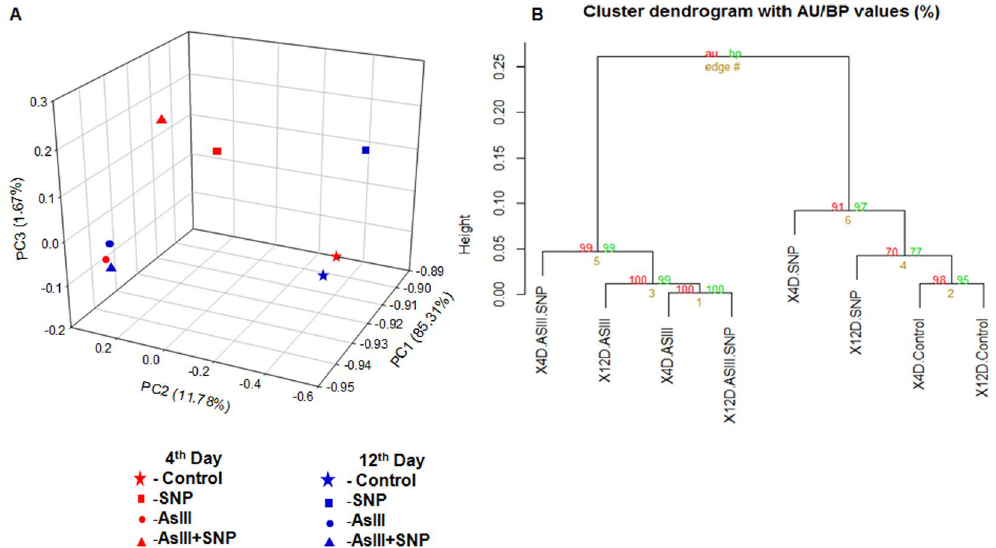
Figure 3. Global transcriptomic correlations among different treatments at both time durations. PCA ( A ) and hierarchal clustering ( B ) showed less variation between control and SNP while significant variation was observed between the control and AsIII + SNP treatment of day 4 th and 12 th day. Expression level was calculated in different samples using FPKM